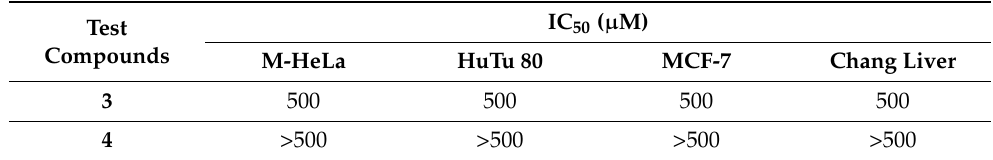
Table 1. In vitro cytotoxic effects (µM) of sulfobetaine derivatives 3 , 4 .